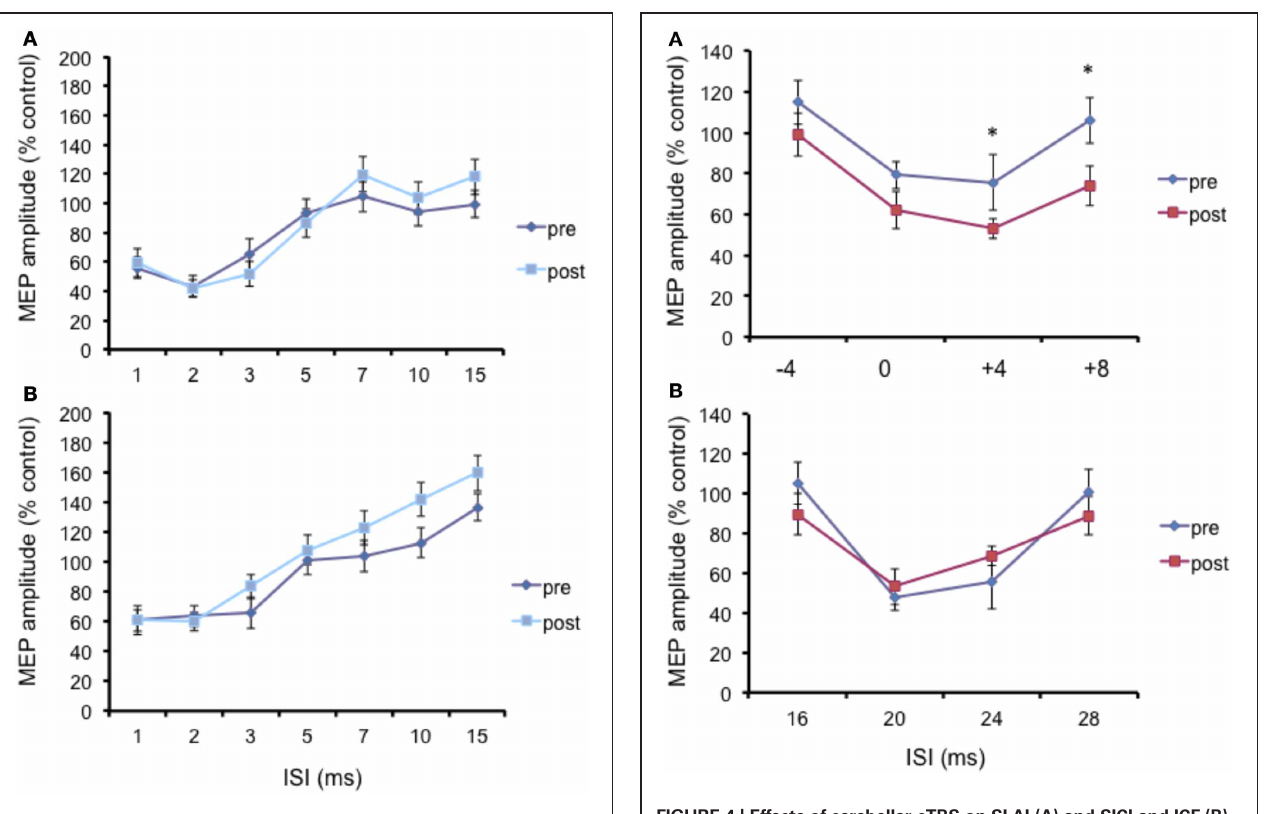
lorazepam resulted in distinct effects on both SICI and